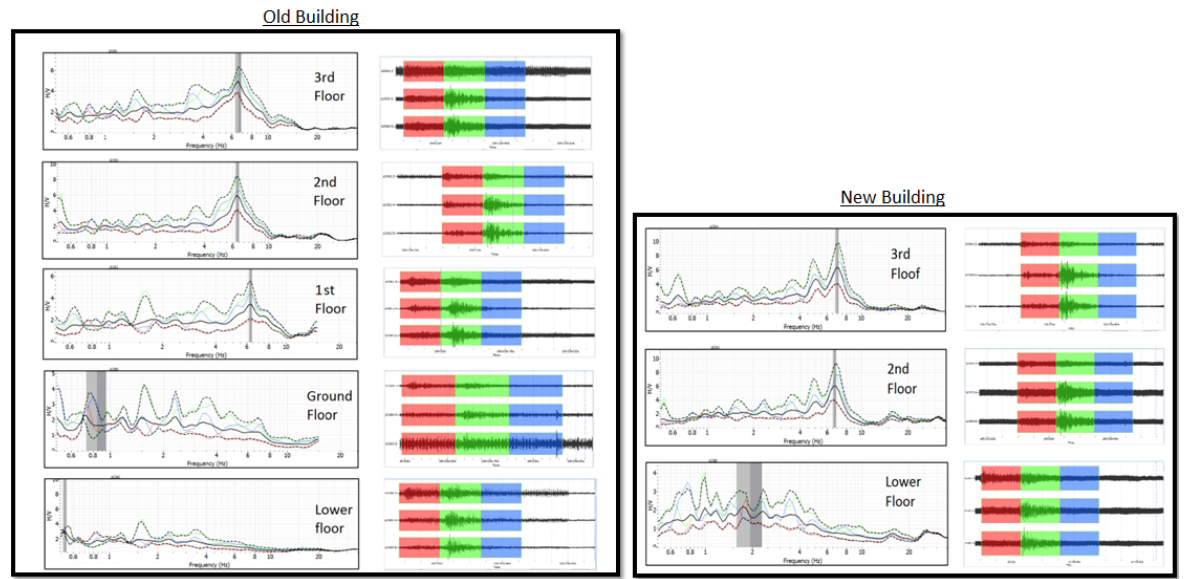
Figure 11. HVSR recordings on 28 April 2013, 16:33UMT (28 April 2013, 19:33LT) on the old (left) and new (right) building of TEI in Chania for the above seismic event. With red colour is 25s window of P wave, with green the 25s window of S wave and with blue the 25s window of after S wave